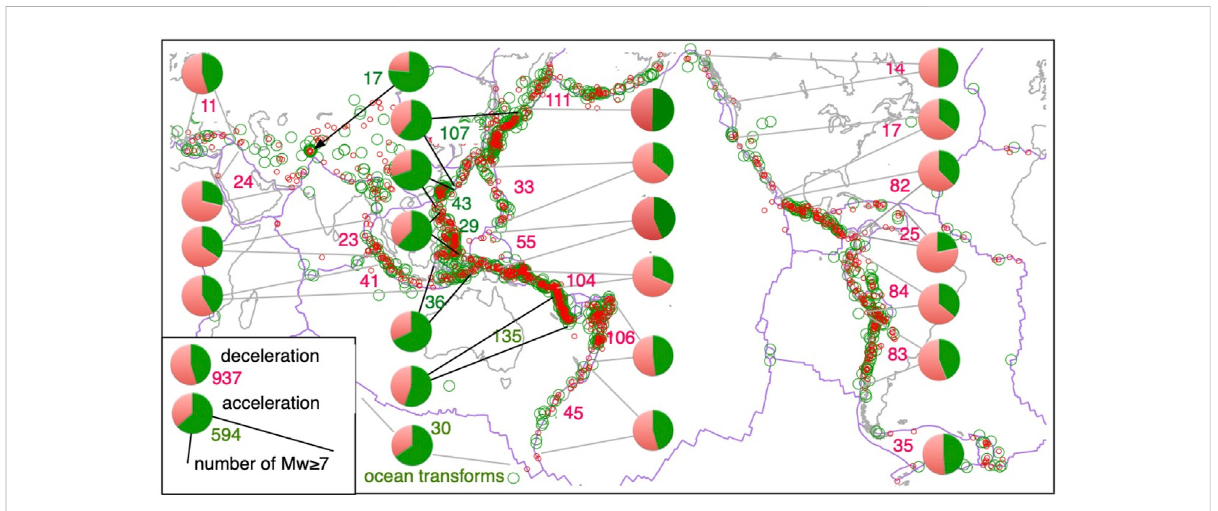
FIGURE 2 Regional distribution of Mw > 7.0 earthquakes 1900 – 2017 (declustered PagerCat), and global distribution lower left inset. Pie-graphs on segments of plate boundaries quantify the proportion of Mw ≥ 7 earthquakes occurring 5 years following prolonged periods of rotational deceleration(red),oracceleration(green)andthetotalnumberofearthquakesconsideredineachpiediagram.Thenumberofearthquakesanalyzed in regional plate boundaries varies from as few as 17 to as many as 135. Acceleration dominant pie-graphs account for only 39% of all earthquakes